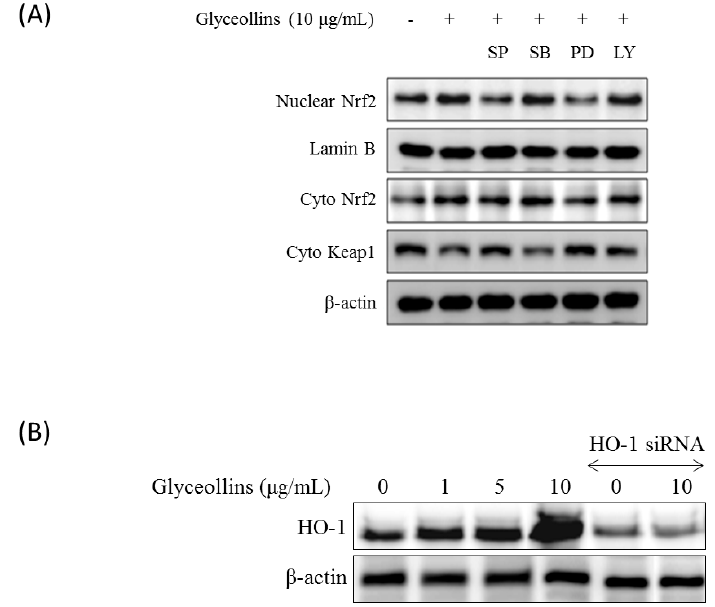
Figure 4. Glyceollin-induced nuclear localization of Nrf2 and HO-1 expression. ( A ) HT22 cells were incubated with glyceollins (10 µ M) and MAPK and PI3K inhibitors for 6 h and separated into nuclear and cytoplasm extracts. Each extract was used for Western blot analysis. Lamin B and β -actin were used as a protein loading control. Inhibitors used are as follows; SP (ERK inhibitor, SP600125), SB (a p38 inhibitor, SB203580), PD (JNK inhibitor, PD98059), or LY (PI3K inhibitor); ( B ) SH-SY5Y cells were incubated with various concentrations of glyceollins for 12 h, followed by Western blot analysis for HO-1 expression. In addition, SHSY5Y cells were transiently transfected with HO-1 siRNA and subsequently treated with glyceollins for 24 h. Whole cell extract was collected and used for Western blot analysis of HO-1 expression. All experiments were conducted in